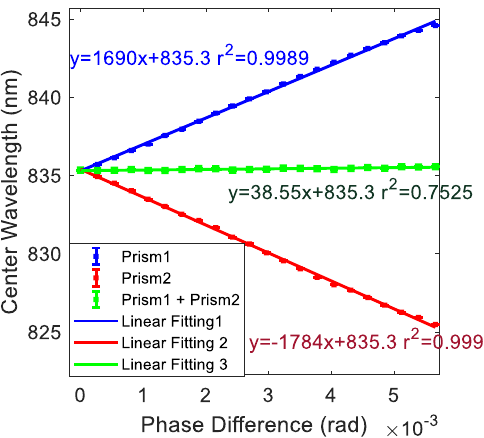
Figure 4. A schematic diagram of the system center wavelength offset as a function of phase difference at different locations within the system.